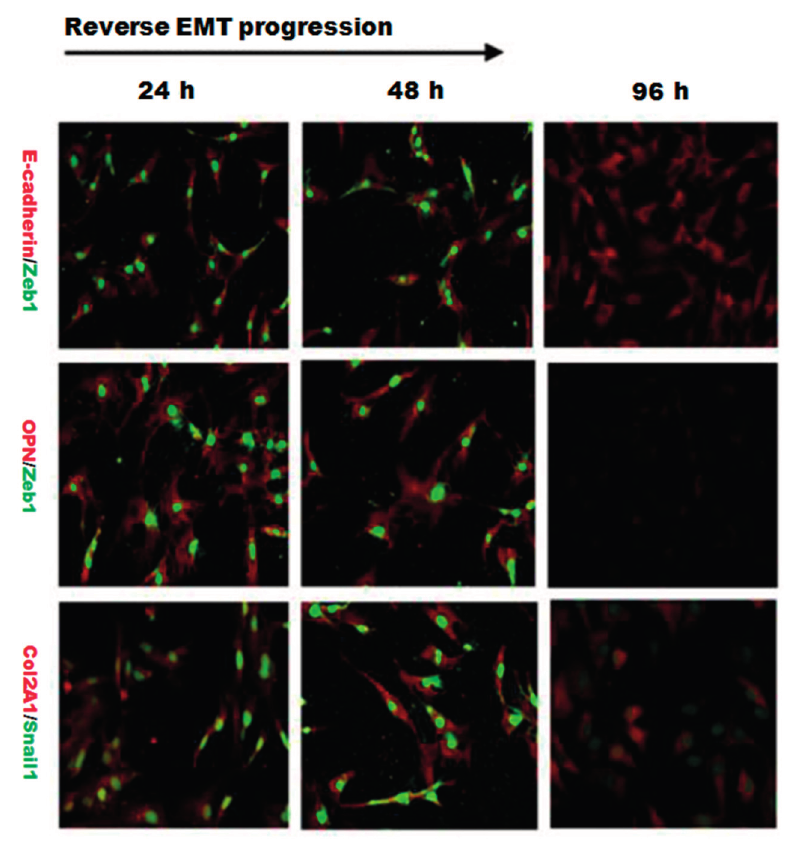
Figure 5. Double immunofluorescence staining showed the dynamic changes in E-cadherin/ Zeb1, OPN/Zeb1 and Col2A1/Snail1 after silencing Wnt11. The fluorescence intensity of Zeb1 (green) in the upper two lines showed a dramatic decreasing trend, indicating that the EMT process was significantly inhibited by Wnt11 depletion in PRECs. The fluorescence intensity of OPN (red), Col2A1 (red) and Snail1 (green) also showed a similar attenuating trend in a time-dependent manner (original magnification: